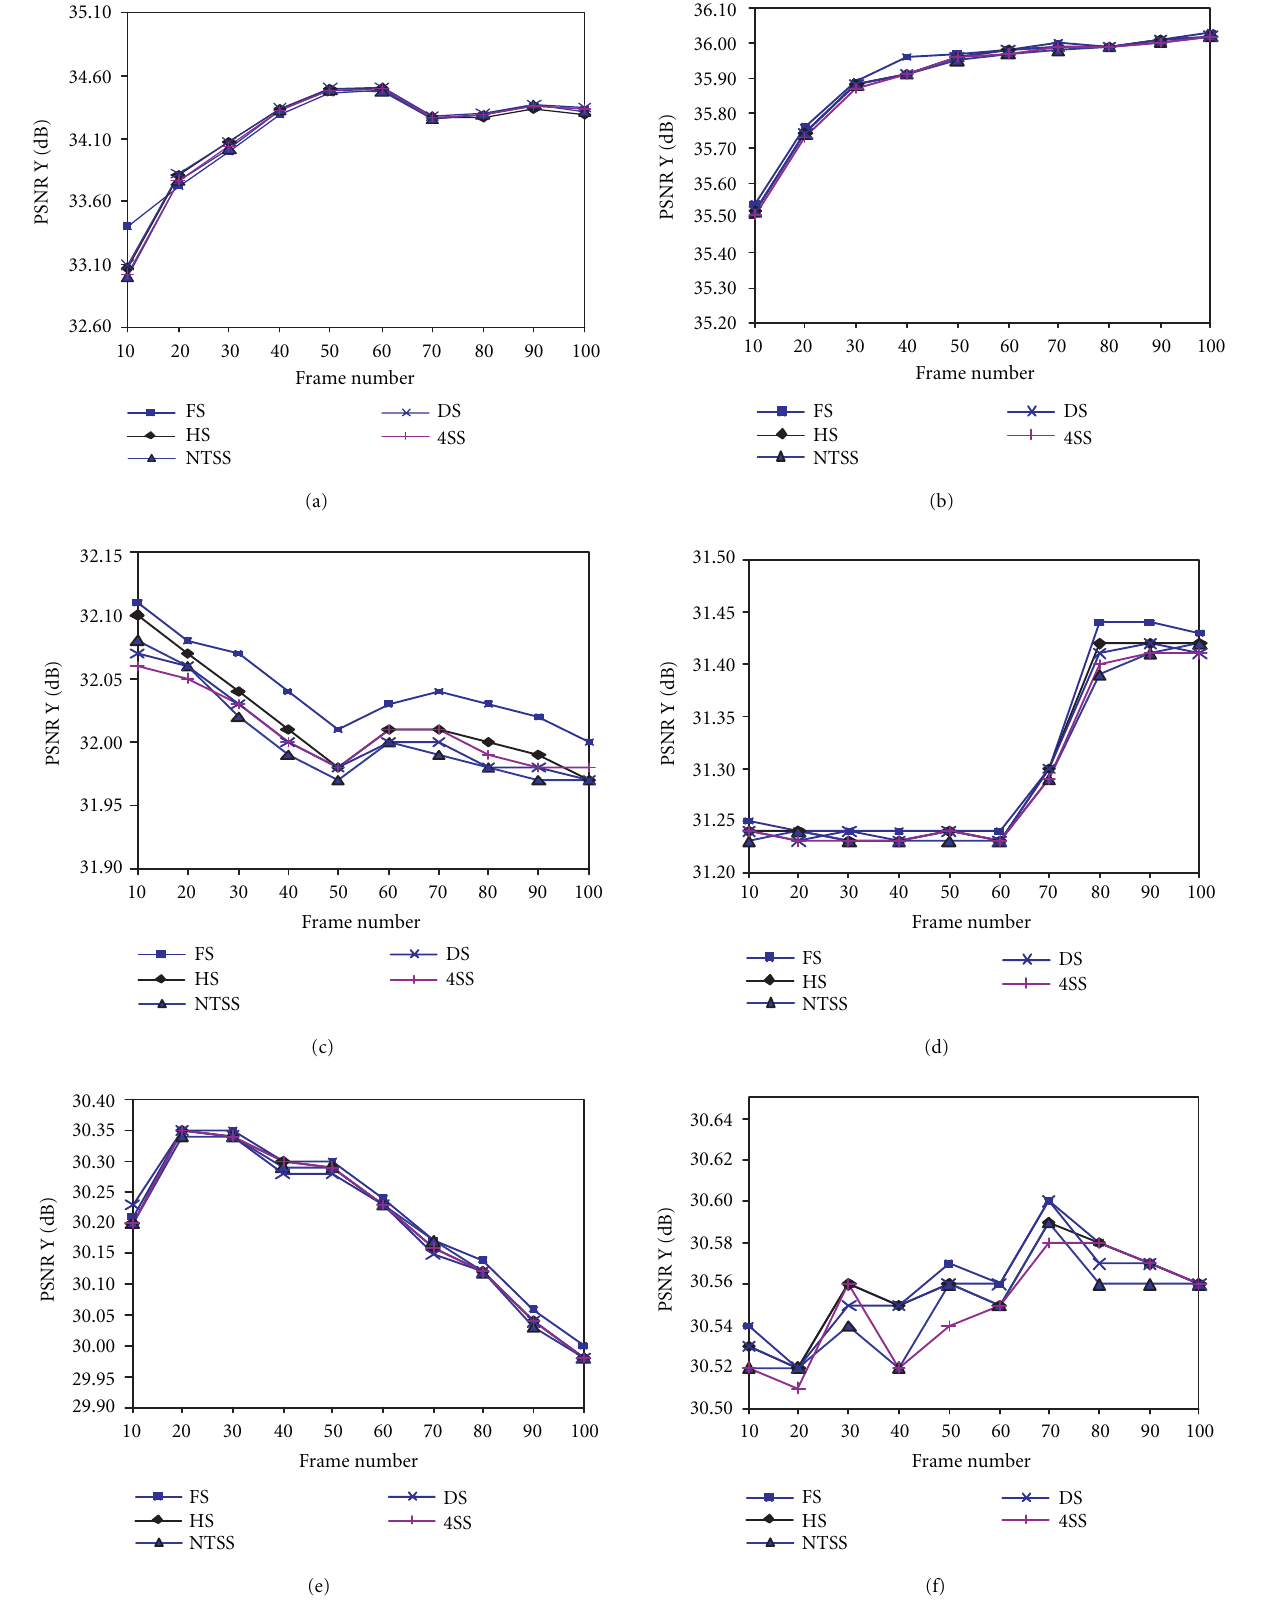
Figure 5: PSNR comparisons of HS, DS, NTSS, 4SS, and FS for (a) Rallycross, (b) News 0, (c) News 1, (d) Coastguard 0, (e) Coastguard 1, and (f)